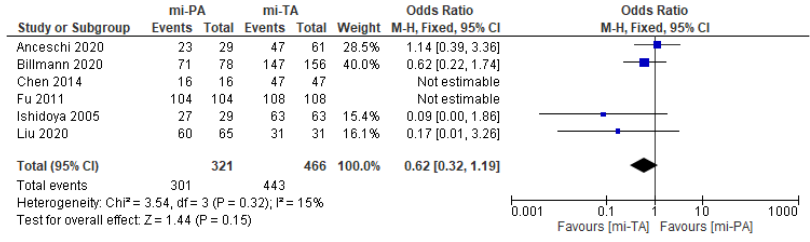
( j ) Forest plot representing analysis of patients with postoperative improved hypertension.